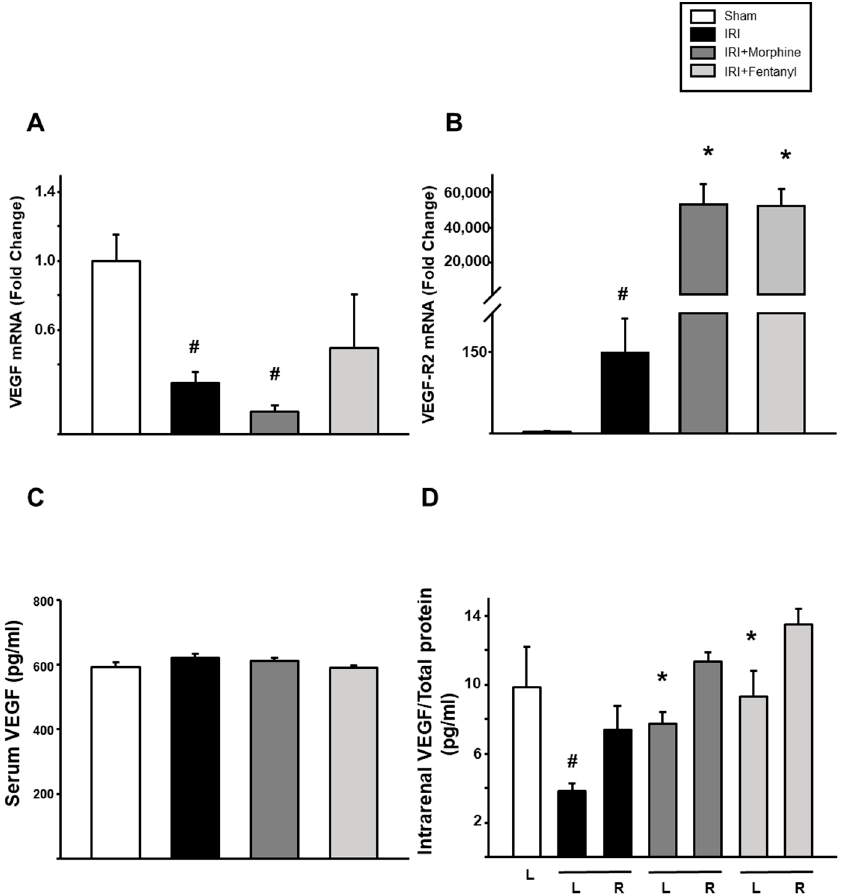
Figure 4. Opioid preconditioning modulated VEGF an VEGF-R2 expression. Quantitative RT-PCR evaluation of mRNA levels of VEGF ( A ) and VEGF-R2 ( B ) in the ischemia-reperfusion treated left kidneys. Circulating ( C ) and intrarenal ( D ) levels of VEGF in the ischemia-reperfusion treated left kidneys (L) and the nontreated right ones (R). Levels were normalized using total protein quantification. Sham group is represented by the white bars, IRI